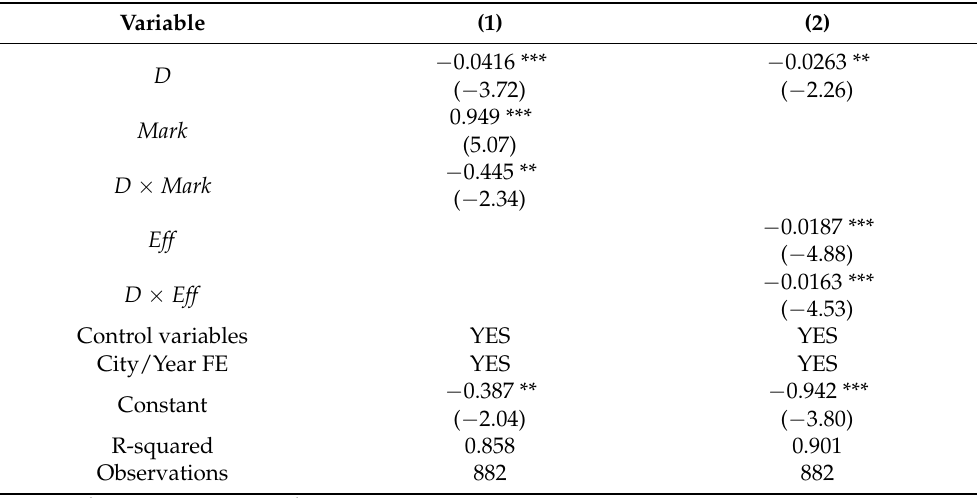
Table 9. Results of the test for adjusting